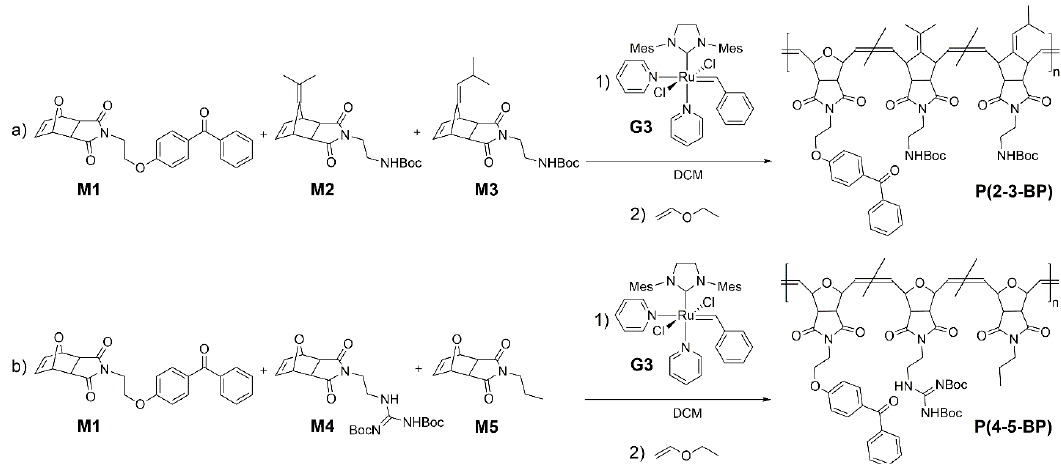
Scheme 2. Copolymerization of M1 with ( a ) norbornene derivatives M2 and M3 , and ( b